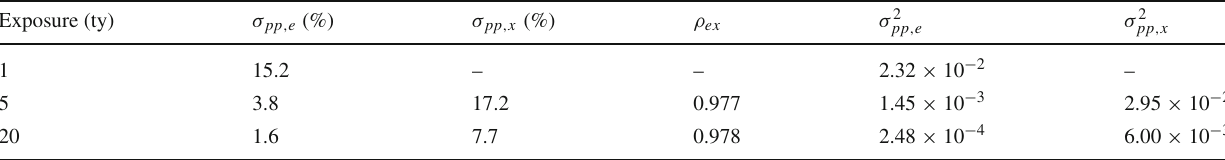
Table 4 The relative uncertainties and variances of the flavor contributions to a pp flux measurement in XENONnT are given with their corre- sponding correlation coefficient for three selected exposures. The fiducial mass of XENONnT is assumed to be around 4 t Exposure (ty) σ pp , e